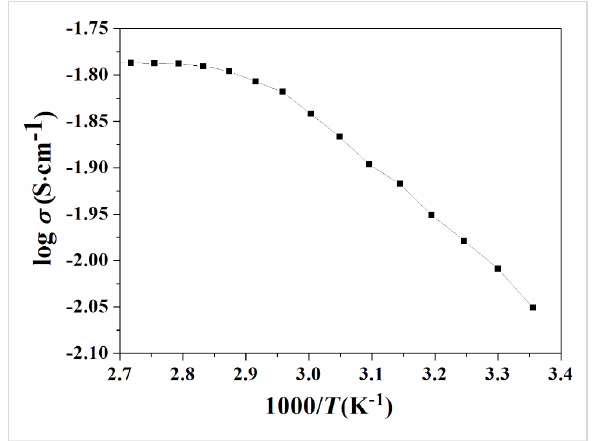
Figure 5: Variation of the electrical conductivity of an optimized polymer gel as a function of the